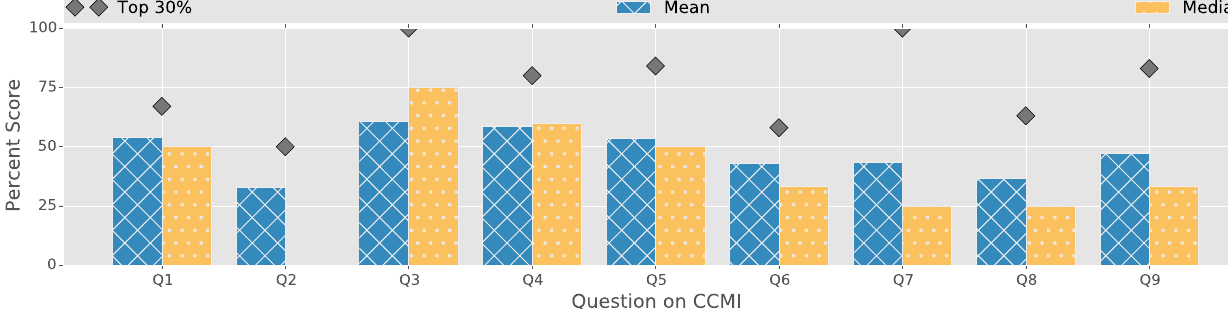
FIG. 6. The mean — blue bar — and median — orange bar — of student performance on each question is provided. The median score for question 2 is zero. In addition, we show the score — gray square — the score that separates the top three deciles from the bottom seven deciles, that is, the score which the top 30 percent of scores lies